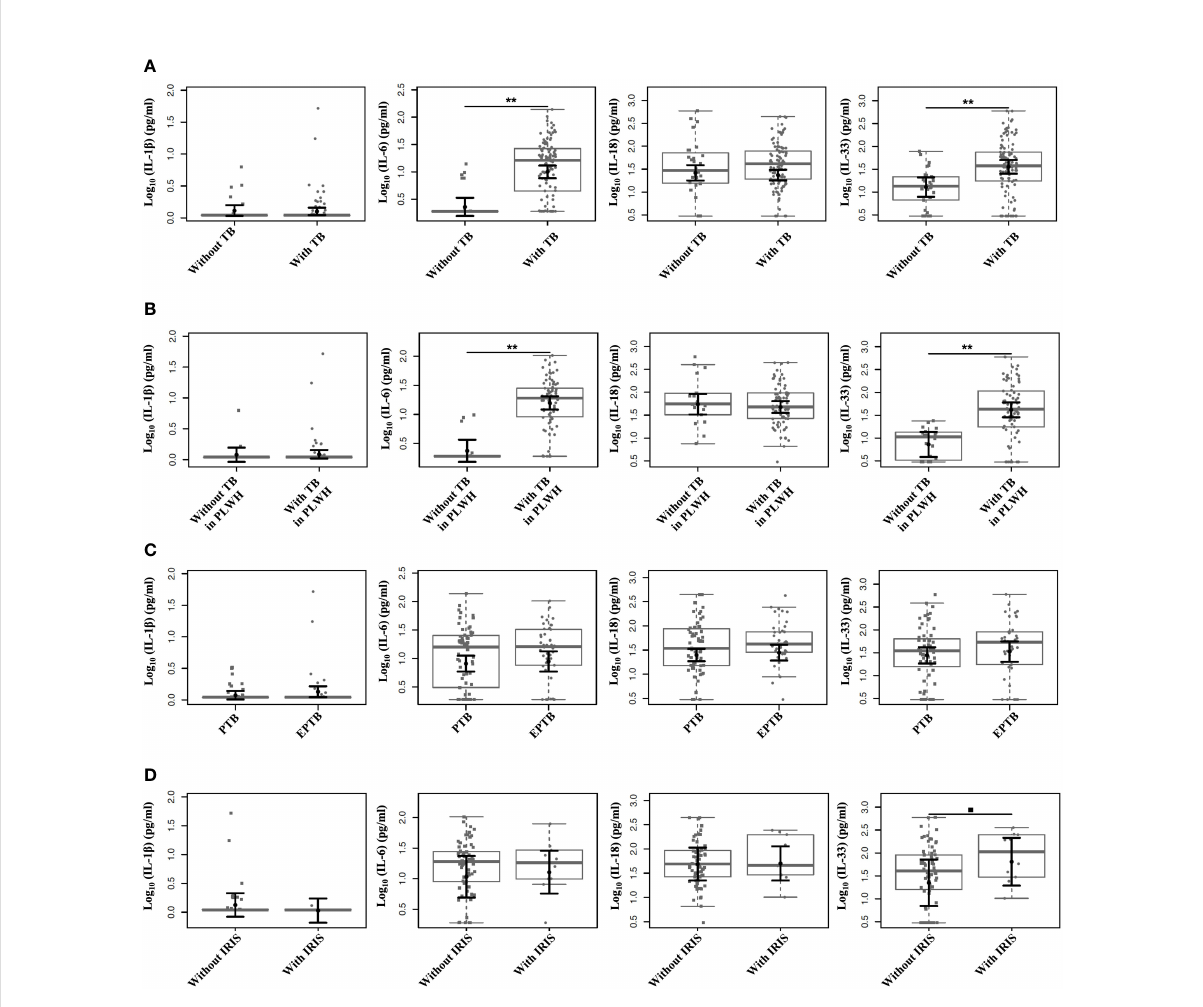
FIGURE 1 Comparison of plasma levels among the individuals included in the study categorized according to the outcomes. Plasma levels of IL-1 b , IL-6, IL-18, and IL-33 measured by distinct ELISAs. (A) Comparison of plasma cytokine levels according to the presence or absence of TB. (B) Comparison of plasma cytokine levels according to the presence or absence of TB among PLWH. (C) Comparison of plasma cytokine levels according to different TB clinical presentations (PTB and EPTB). (D) Comparison of plasma cytokine levels according to the presence or absence of IRIS. Boxplots show the IQRs and sample medians (central solid gray line). Least-square means of log-transformed (base 10) levels of cytokines were pairwise compared among groups with T tests. Adjustments to the con fi dence levels were made by Sidak ’ s method, and P value adjustments were made by multiple comparisons using Tukey ’ s method. ** P <0.0001; (cid:129)